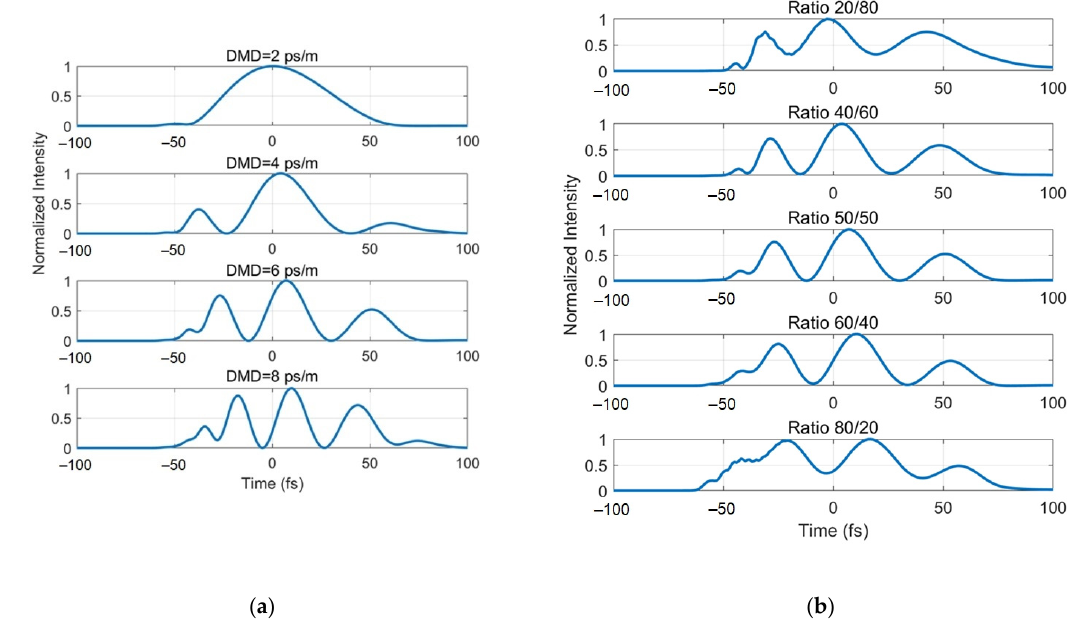
Figure 5. The simulation results of the responses at the fiber output: ( a ) with uniform excitation of modes per input, depending on the mode delay; ( b ) with a mode delay of 6 ps/m depending on the power distribution between modes at the input.